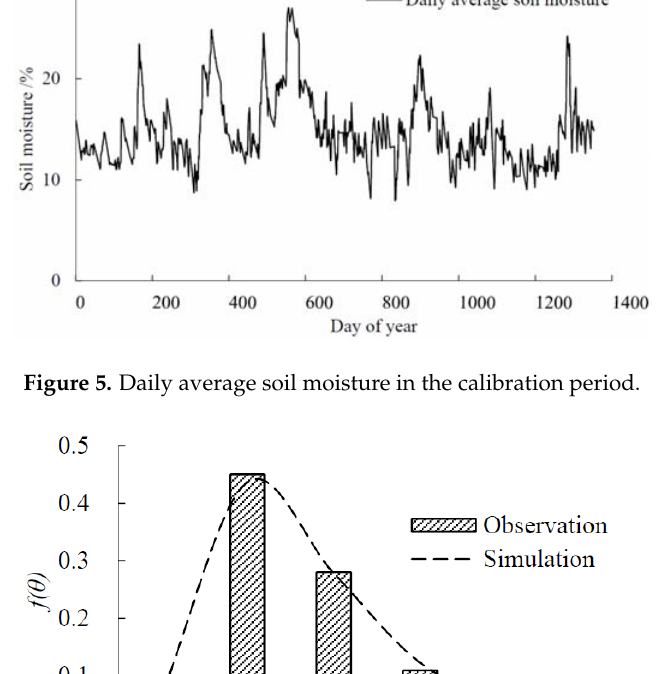
14 of 27 Table 6. Optimum model parameter values obtained by a genetic algorithm approach. Parameters